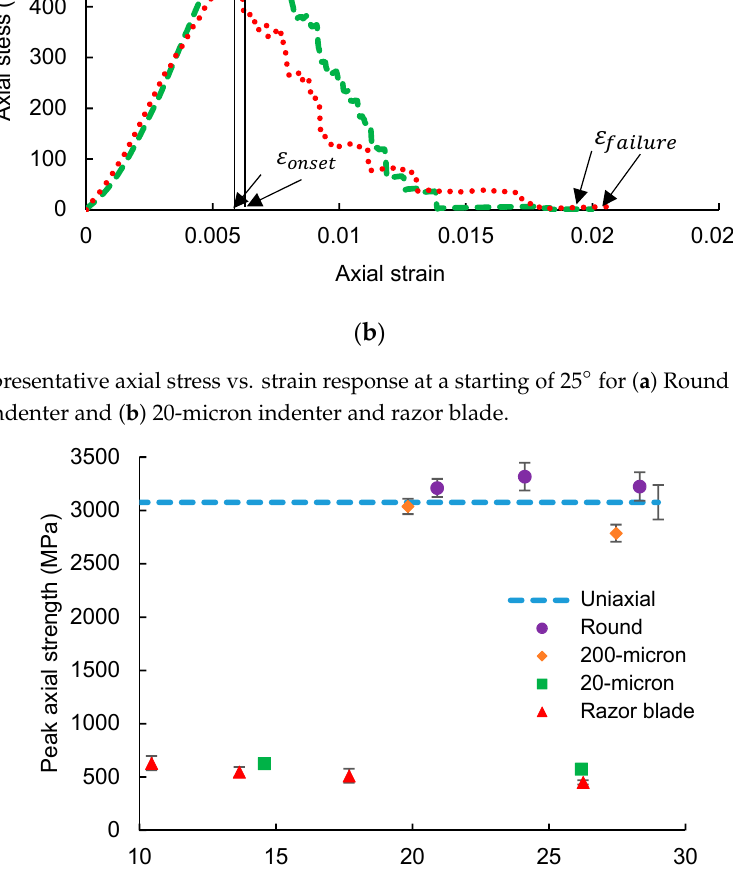
Figure 9. Effect of the breaking angle on axial strength for different indenter geometries.